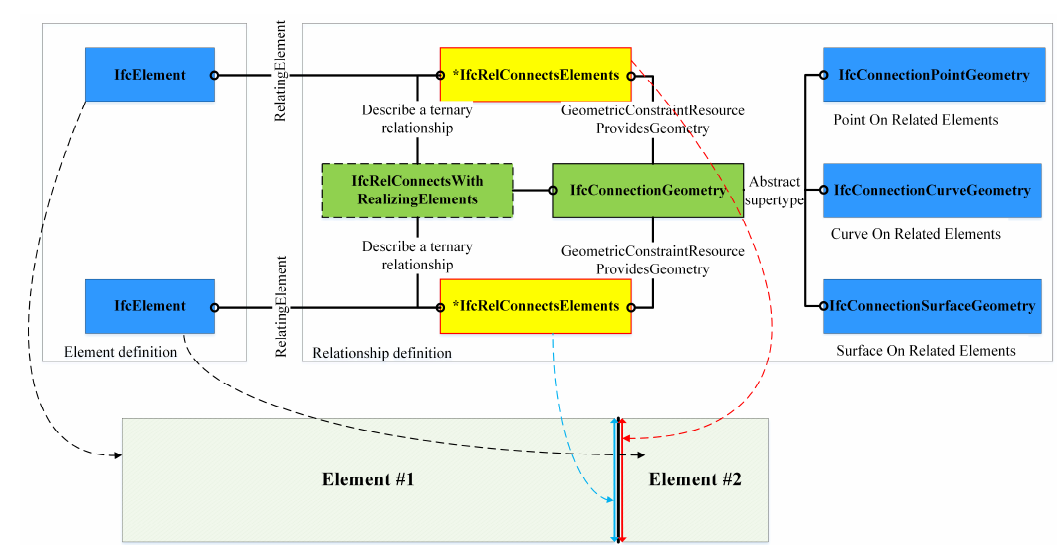
Figure 11. The EXPRESS-G representation of element connection in BIM.